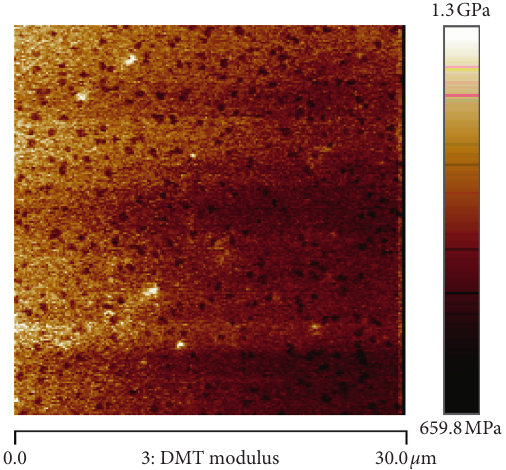
Figure 11: DMT modulus diagram of #70 matrix asphalt+ 30% activated Buton rock powder.